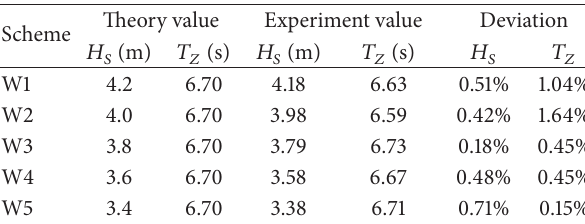
Figure 8: Pressure gauges arrangement. Table 3: Comparison of irregular waves parameter.